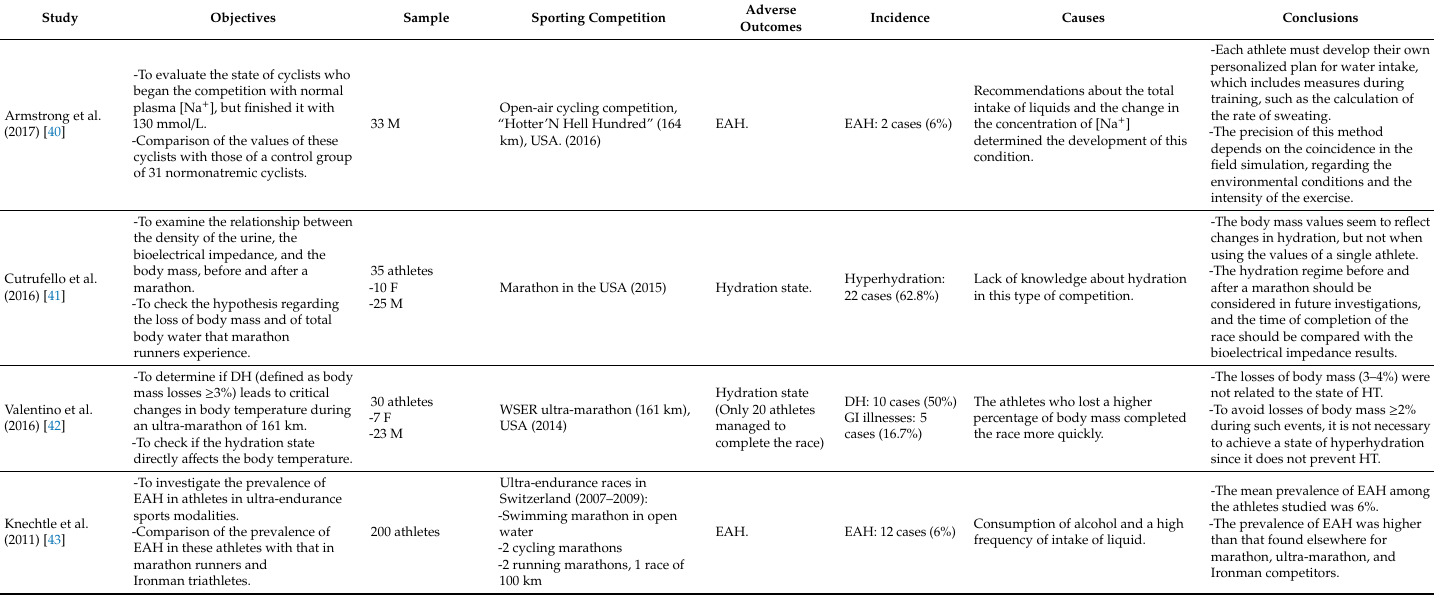
Table 2. Nutrition-related adverse outcomes in competitions and endurance and ultra-endurance sports, investigated in randomized clinical trials. Study Objectives Sample SportingCompetition Adverse Outcomes Incidence Causes